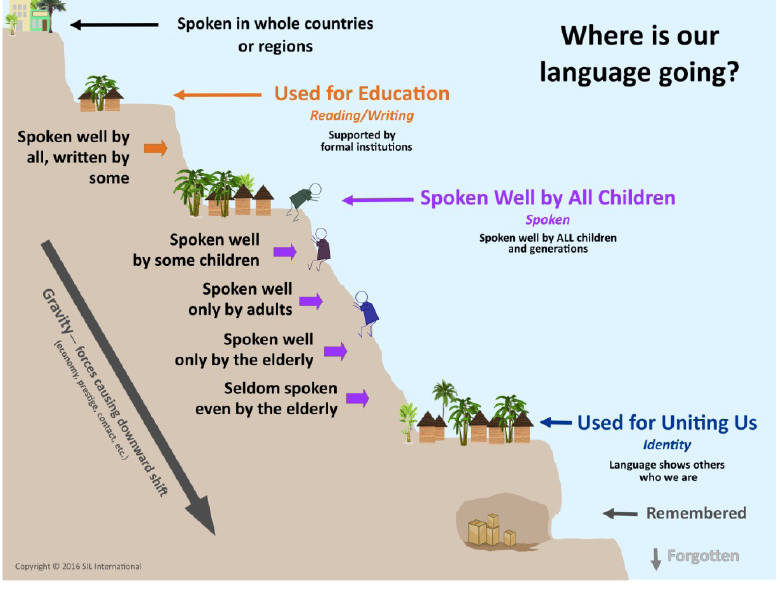
Figure 2. The EGIDS ‘mountain’ metaphor, from ‘Guide for Planning the Future of Our Language’,